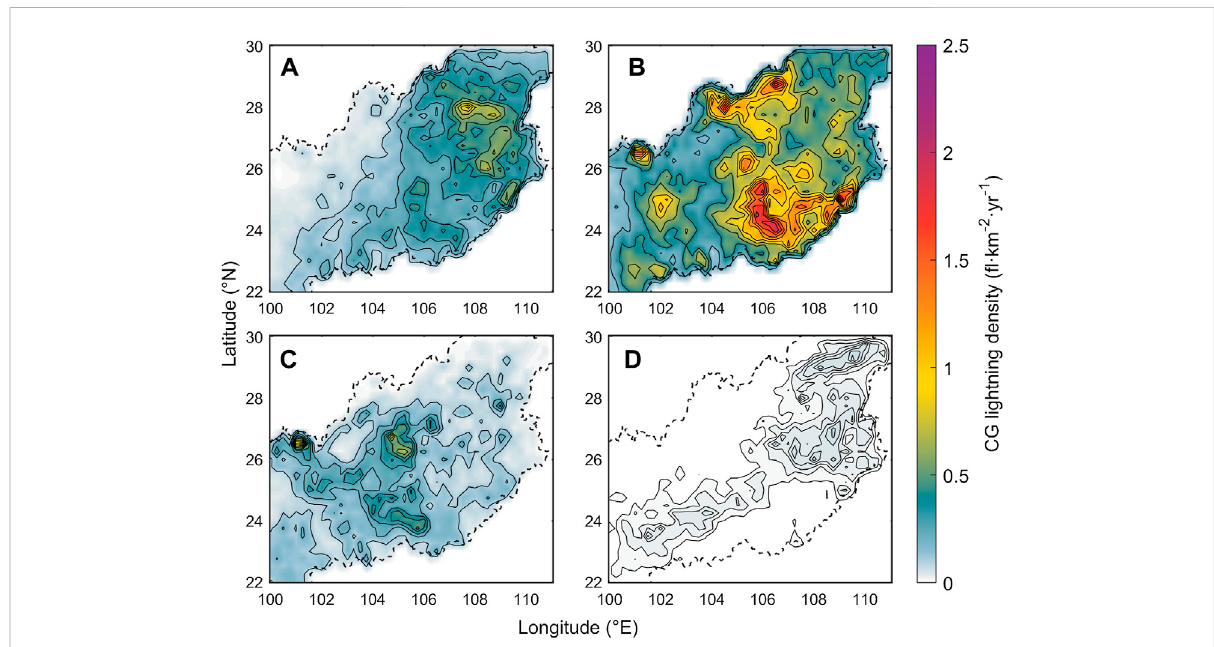
FIGURE 4 The seasonal distribution of average lightning density on the Yungui Plateau between 2016 and 2020: (A) Spring, (B) Summer, (C) Autumn, and (D) Winter.